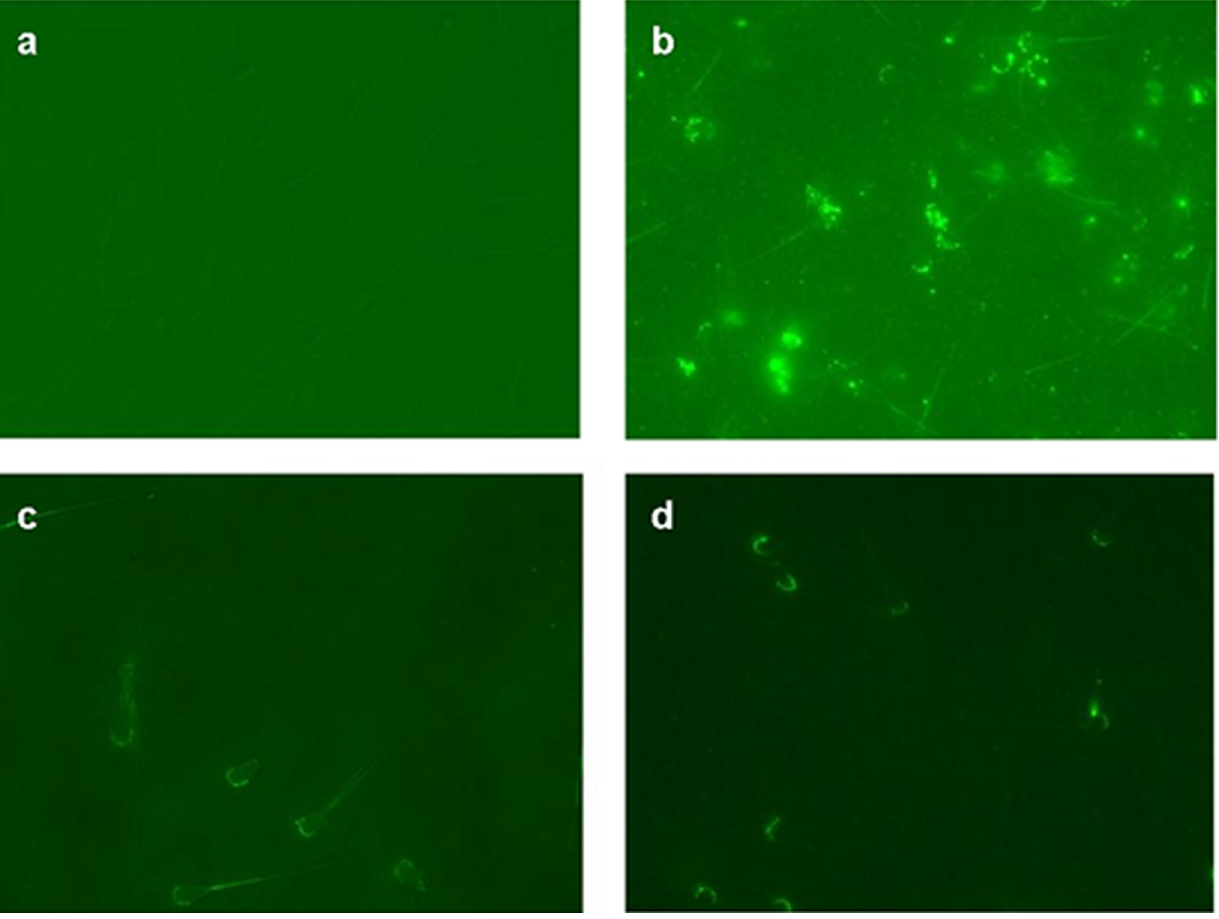
Figure 1. Visualization of representative control and treatment sperm samples included the following: a) fertility associated antigen (FAA) antibody control sample (FAA negative) without FAA present on sperm (provided by Midland Bioproducts Corporation H ) and verified after the application of fluorescein conjugated FAA antibody, b) FAA protein control sample (FAA negative, provided by Midland Bioproducts Corporation H ) with fluorescein conjugated FAA recombinant protein added to sperm, c) fluorescein conjugated Type-2 tissue inhibitor of metalloproteinase (TIMP-2) antibody added to sperm, and d) fluorescein conjugated TIMP-2 protein added to sperm.